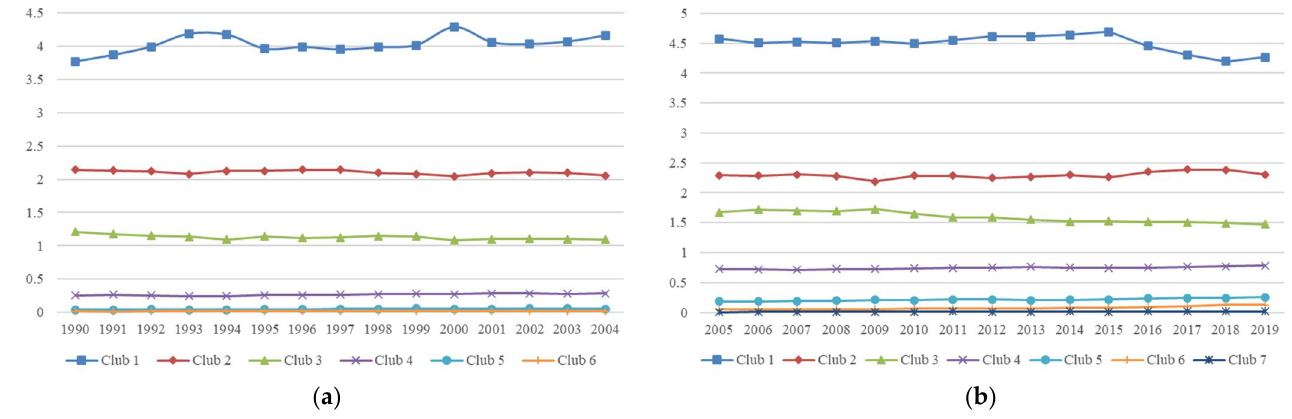
Figure 2. ( a ) Relative transition path curves of convergence clubs in AKP period; ( b ) relative transition path curves of convergence clubs in PKP period.